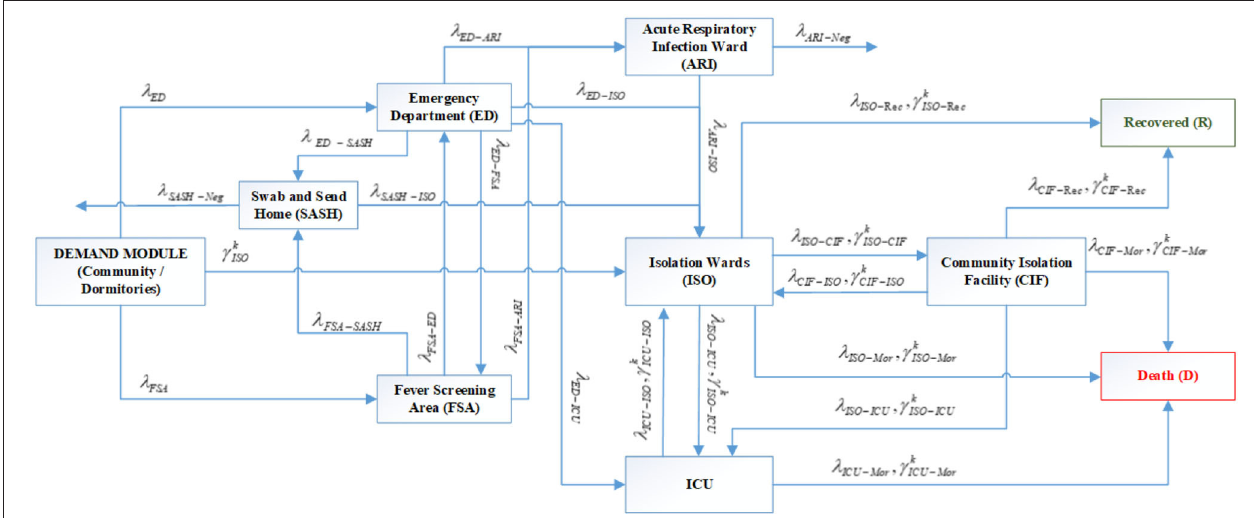
FIGURE 3 | System flow schematic of Variants 2 and 3 with specialized inflows from community and dormitories in the demand module (Notations: G : Set of age groups, k ∈ G ; λ i : Arrival rate of suspect cases from community to server i where i = where k ∈ G ; λ p − q , γ k p − q : Transfer rate of community cases and dormitory cases of age group k , respectively, from server p to server q where k ∈ G ,